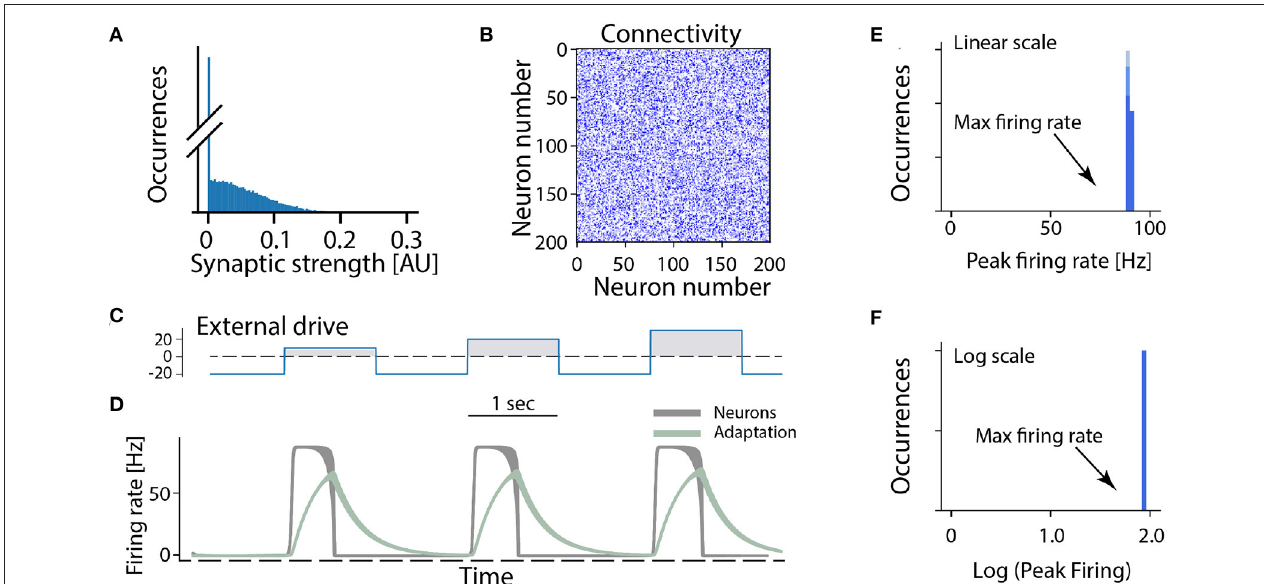
FIGURE 3 | All-or-none behavior of recurrent excitatory networks: model. (A) Distribution of synaptic strengths in the model is a truncated Gaussian, with many having zero (no connection). (B) Connectivity matrix of the non-zero connections in the network composed of 200 excitatory neurons. (C) The external drive to the network has to be kept negative (inhibitory) to keep it silent because the network is unstable (supercritical). Positive pulses was given with increasing amplitude imitating a rhythmic drive. (D) The firing rate of the neuronal population (gray overlay) has a prompt increase to maximal firing once the external drive becomes positive. Intrinsic adaptation (green traces) curbs the activity and turns the firing off after some time. Note the population firing is at maximum regardless of input size. (E,F) The linear and log distributions of peak firing rates across population have a single mode at maximal firing (arrows) regardless of the